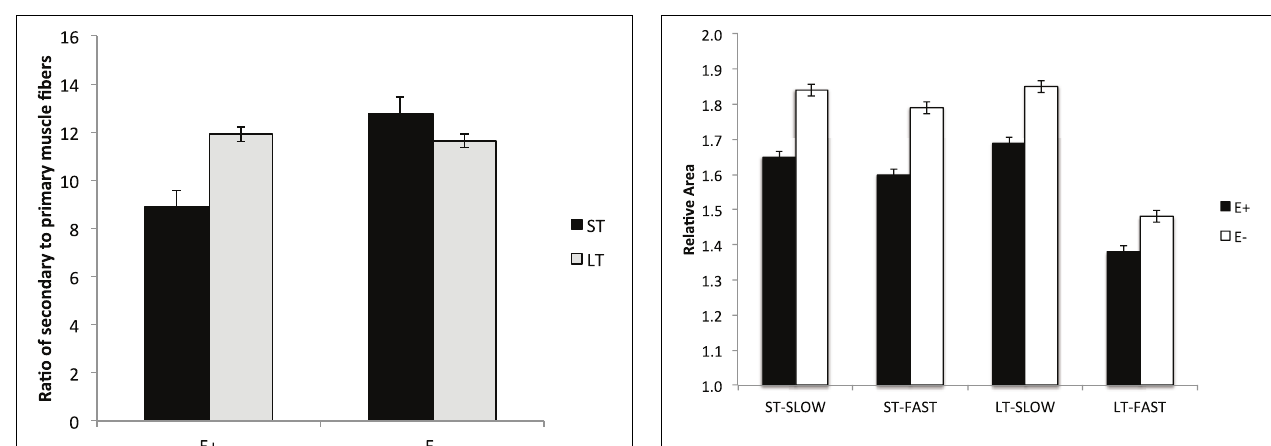
FIGURE 5 | Cross sectional area of muscle fibers (slow- and fast-MHC) in the longissimus thoracis (LT) and semitendinosus (ST) muscles in lambs from dams fed tall fescue seed containing endophyte (E + ) vs. endophyte-free (E − ) during gestation. Treatment was significant ( P < 0 . 001) for both LT and ST